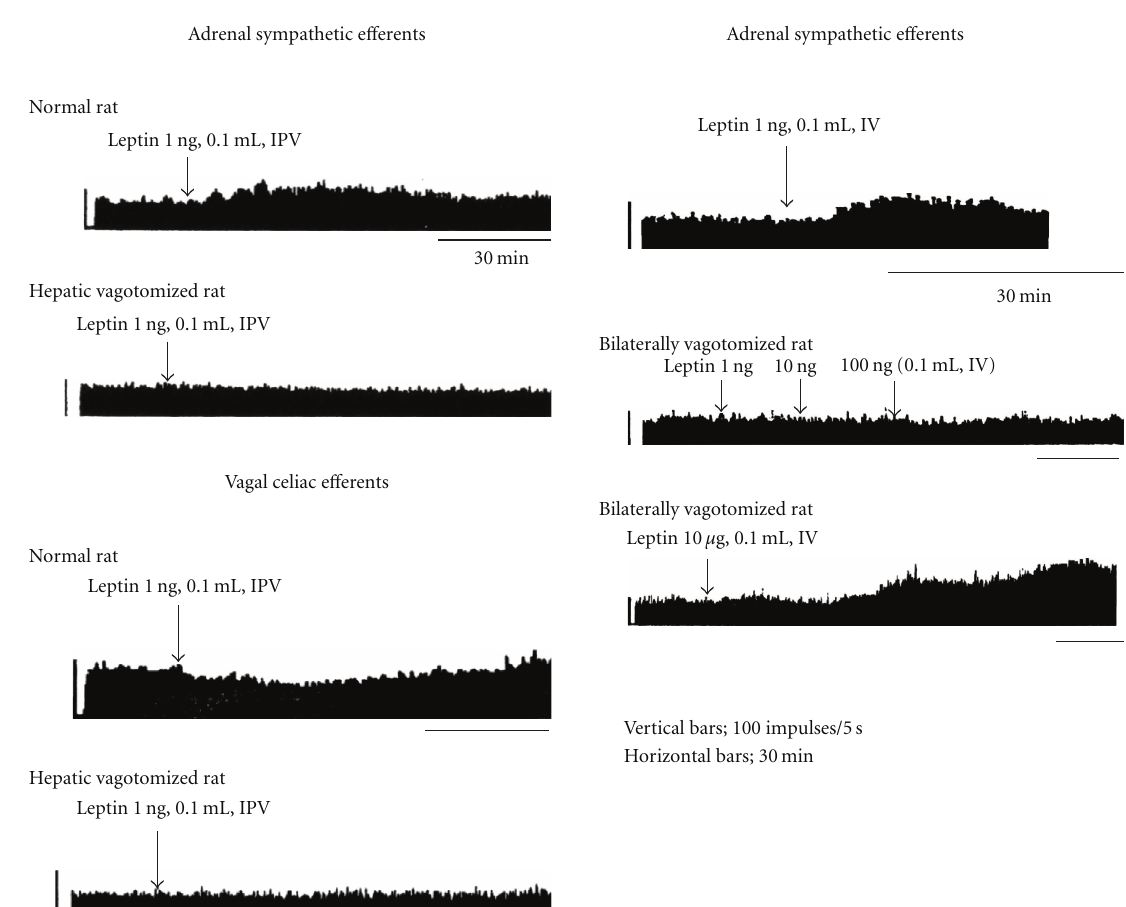
Figure 5: E ff ects of IPV or IV injection of leptin on the e ff erent activity of sympathetic nerve and vagus nerve in normal and hepatic or total vagotomized rat.